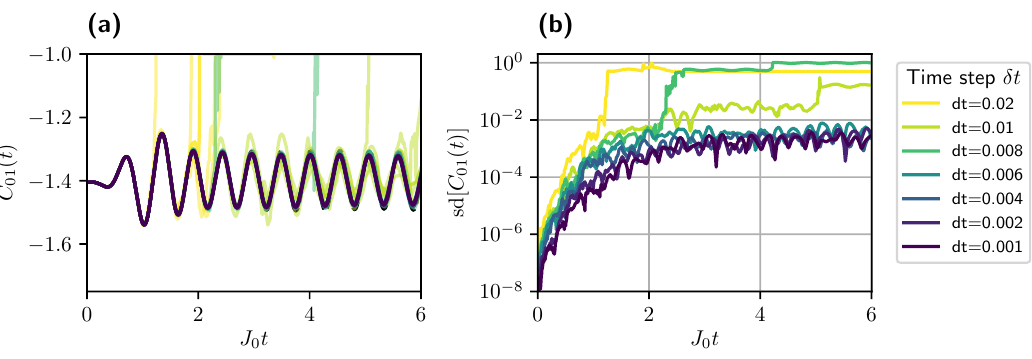
Figure 5: (a),(b) Same trajectories as in Fig. 4 [ (a),(b) ] for a driving strength of = 0.10 and with varying time step δ t at a fixed noise level of η = 10 − 3 A p